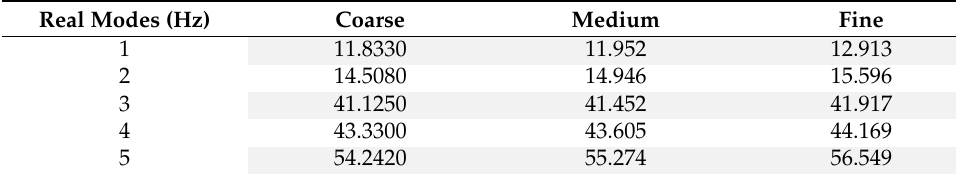
Table 13. Nominal mesh sensitivity results (Fully Fuelled Rocket).